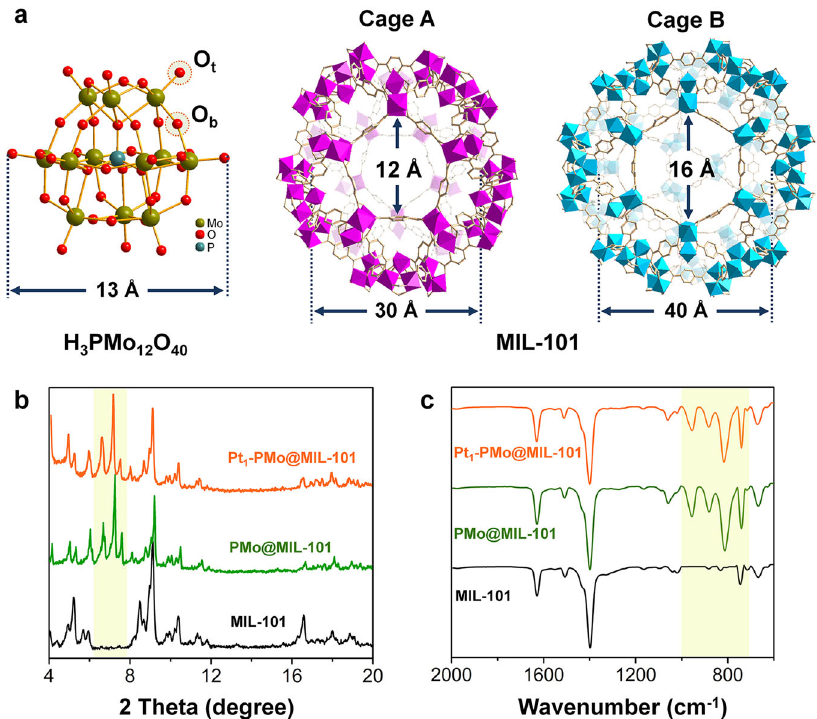
Fig. 2 Structure and characterizations of H 3 PMo 12 O 40 , MIL-101, and PMo@MIL-101. a The crystalline structures of Keggin-type H 3 PMo 12 O 40 and the pore structures and aperture size of MIL-101. O t : terminal oxygen, O b : bridge oxygen. b PXRD of MIL-101, PMo@MIL-101, and Pt 1 -PMo@MIL-101, respectively. c FTIR of MIL-101, PMo@MIL-101, and Pt 1 -PMo@MIL-101, respectively.